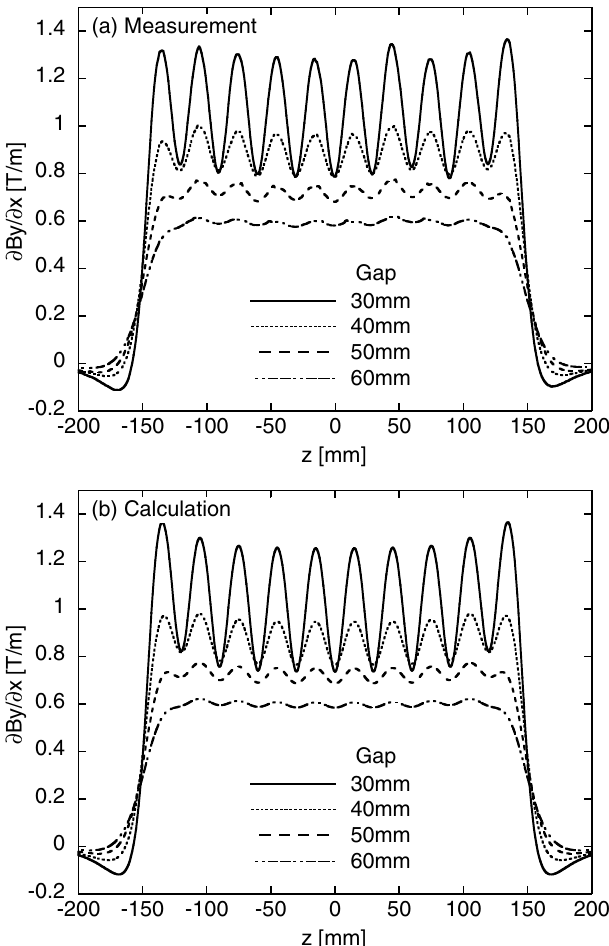
FIG. 9. Measured and calculated vertical field gradients =@x ) of the EF wiggler along the wiggler axis at wiggler ( @B y gaps of 30, 40, 50, and 60 mm.